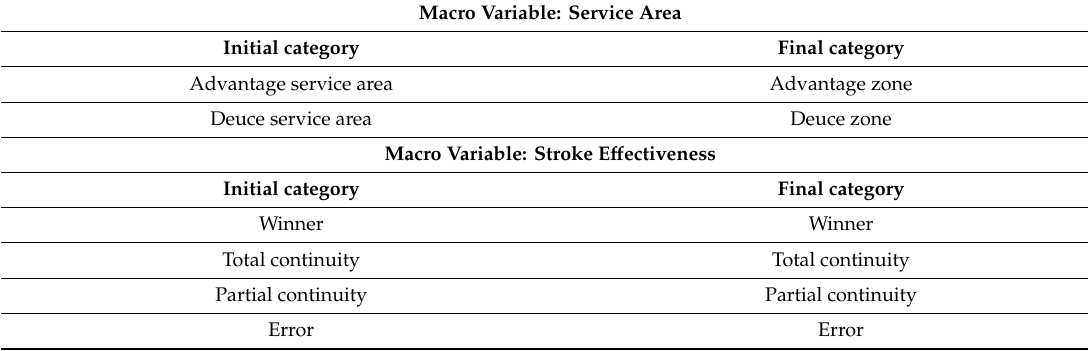
Table 1. Macro variables, micro variables, initial category of the observational instrument (initial category) and their final transformation for this study (final category).